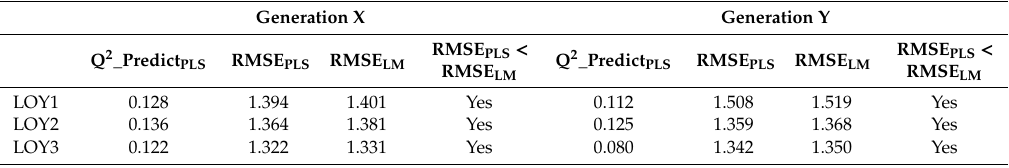
Table 8. Generation X vs. Generation Y model predictive power